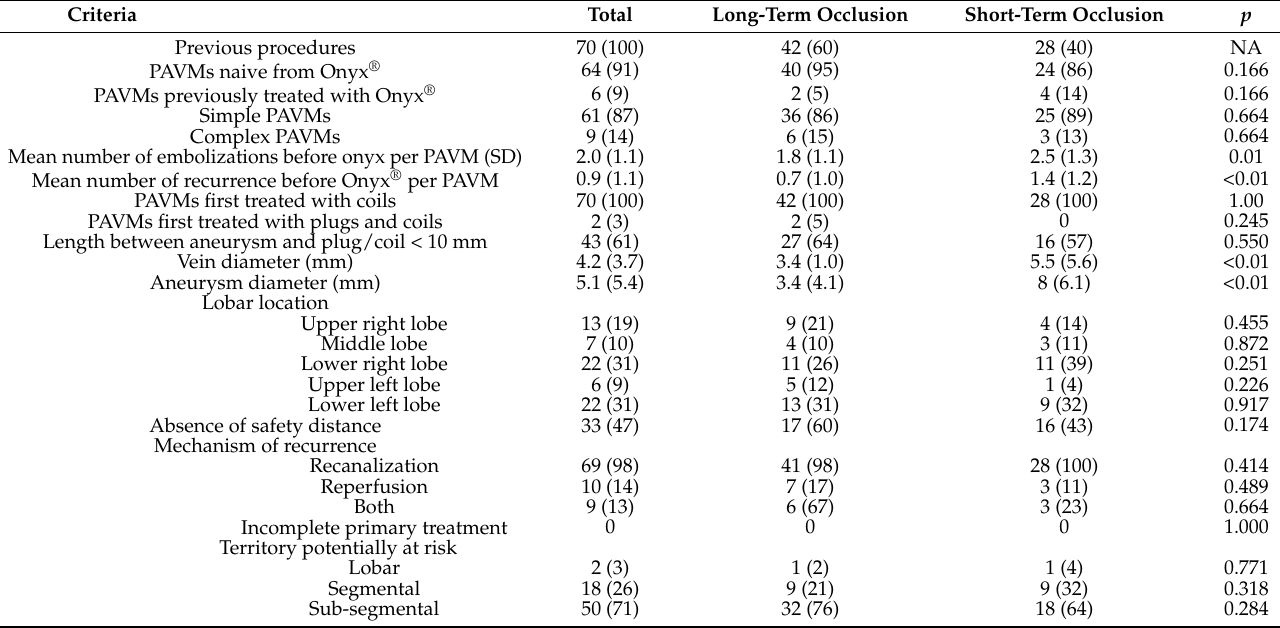
Table 2. Pulmonary arteriovenous malformation data before embolization in the overall population and in the two groups (short- and long-term occlusion).